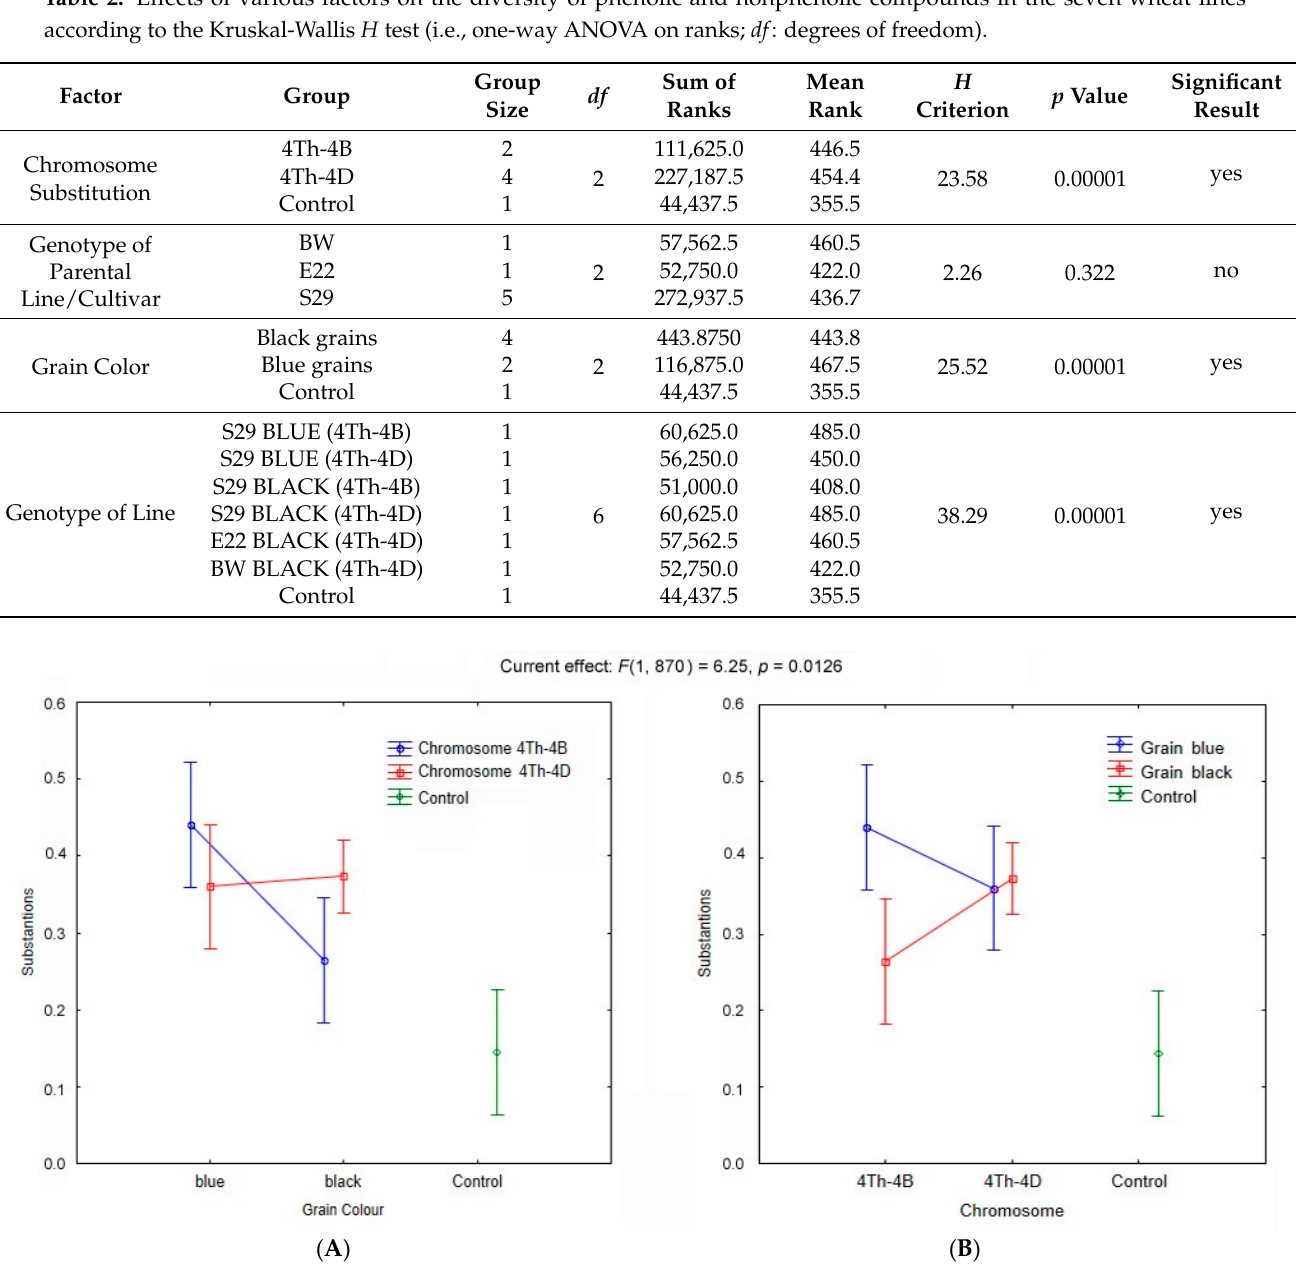
Figure 6. Effects of the factors “Chromosome Substitution” and “Grain Color” on diversity of chemicals in wheat grain assessed in groups of lines combined based on grain color ( A ) and substituted chromosomes ( B ), respectively, according to two-way ANOVA (Fisher’s F test). Vertical bars denote 0.95 confidence